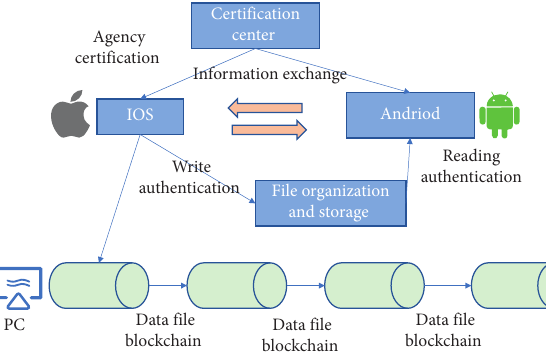
Figure 3: Functional module